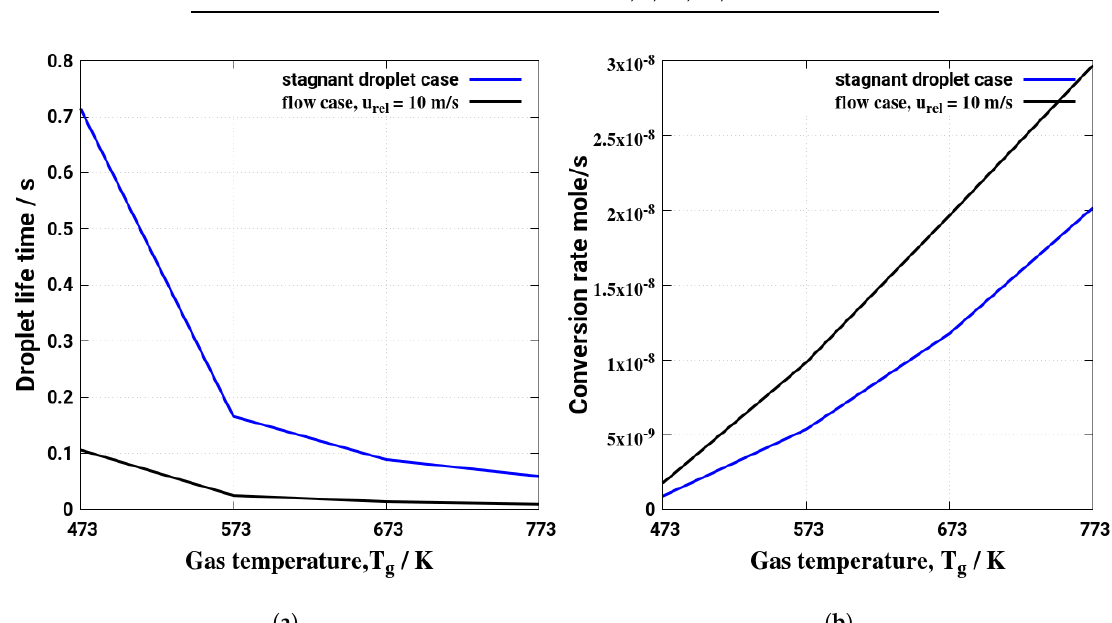
Figure 4. Comparison of evaporation/conversion dynamics of d p = 50 µ m for stagnant droplet u rel = 0, and with relative velocity u rel = 10 m/s: ( a ) droplet lifetime; ( b ) average NH 3 conversion